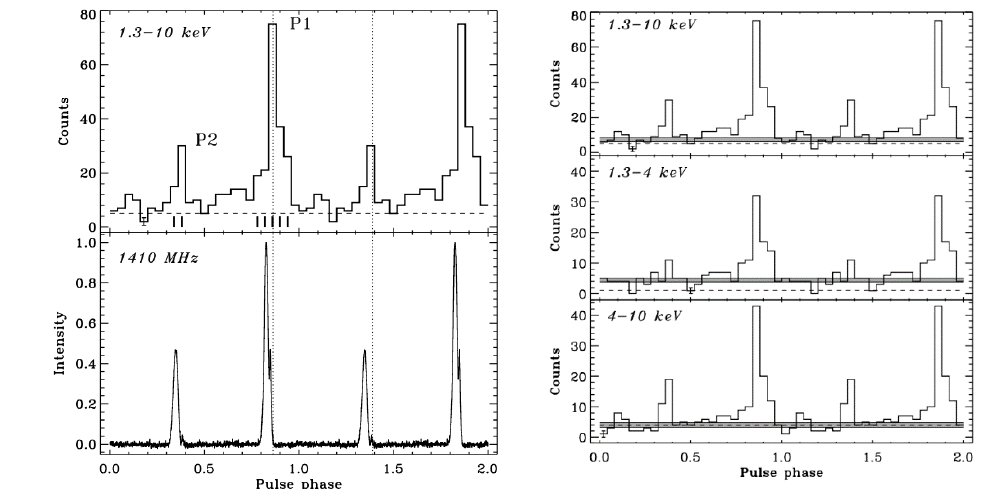
Figure 1. Radio pulse profile and the 1.3–10 keV BeppoSAX X-ray profile phase aligned with the radio giant pulses.